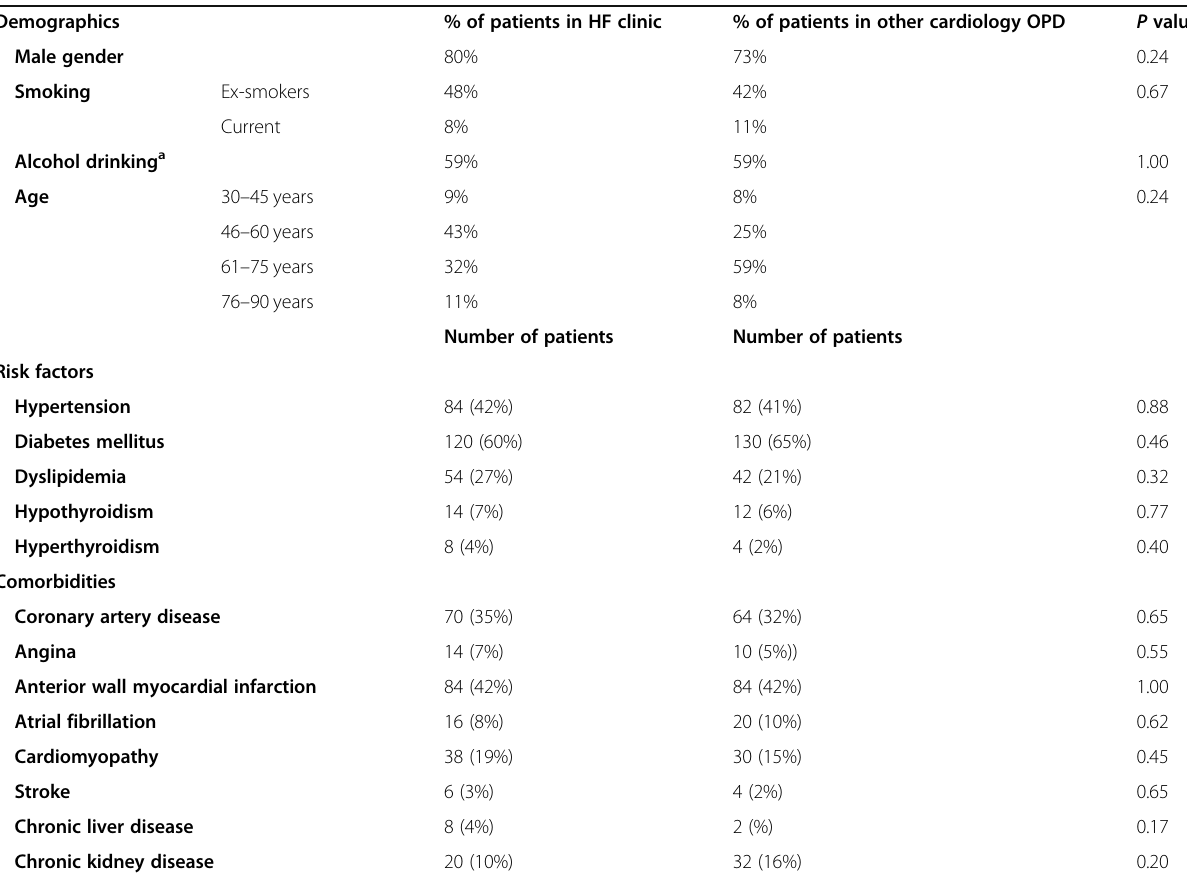
Table 1 Demographic characteristics